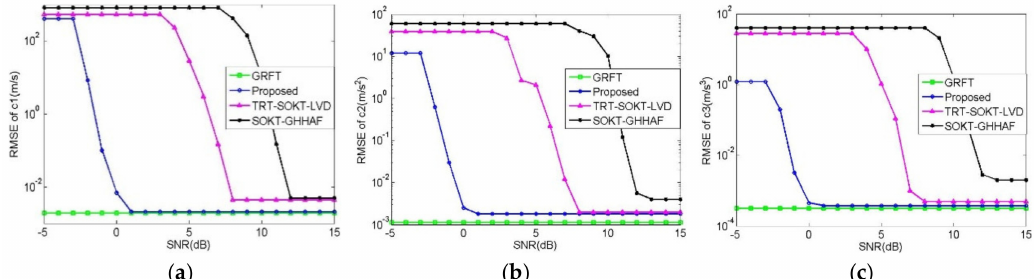
Figure 8. Relationships between root-mean-square errors (RMSEs) of motion parameters and input SNRs. ( a ) RMSE of estimated first-order coefficient varying with input SNRs. ( b ) RMSE of estimated second-order coefficient varying with input SNRs. ( c ) RMSE of estimated third-order coefficient varying with input SNRs.